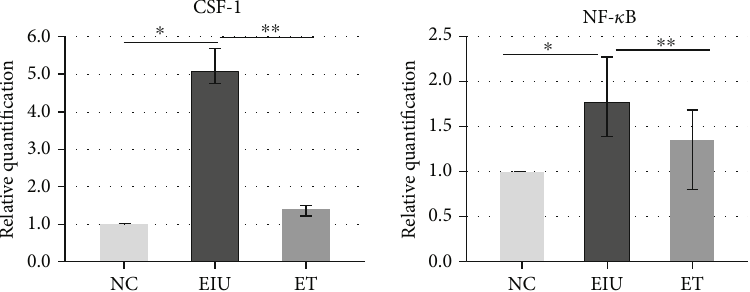
Figure 4: Real-time PCR of CSF-1 and NF- κ B P65 in ICB. The mRNA expression of CSF-1 and NF- κ B P65 in the EIU group were signi fi cantly higher than that in the NC group ( ∗ P < 0 : 05 ) and ET group (CSF-1: F = 602 : 127 , ∗∗ P < 0 : 05 ; NF- κ B P65: F =24.173, ∗∗ P < 0 : 05 ). All data shown as mean ± standard deviation from ten independent